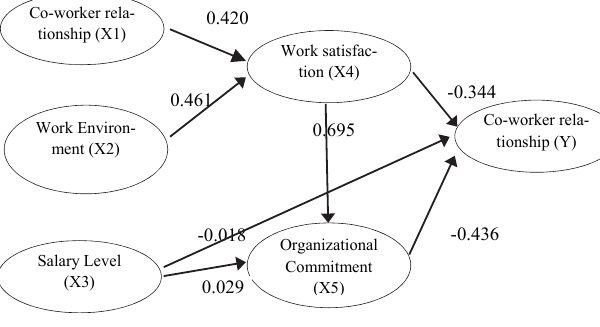
Fig. 2. Partial Least Square